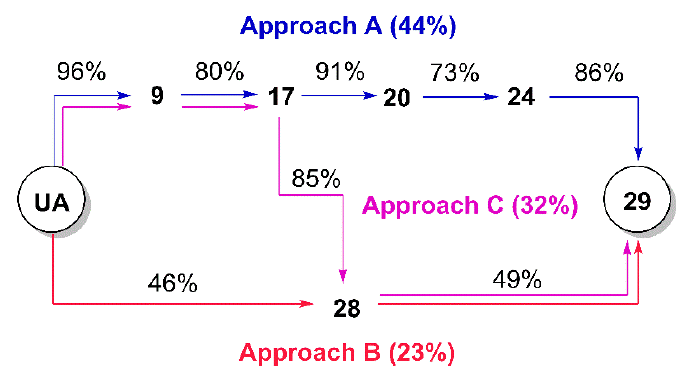
Figure 2. Comparison of synthetic routes A , B , and C for the preparation of UA-DOTA conjugate 29 .